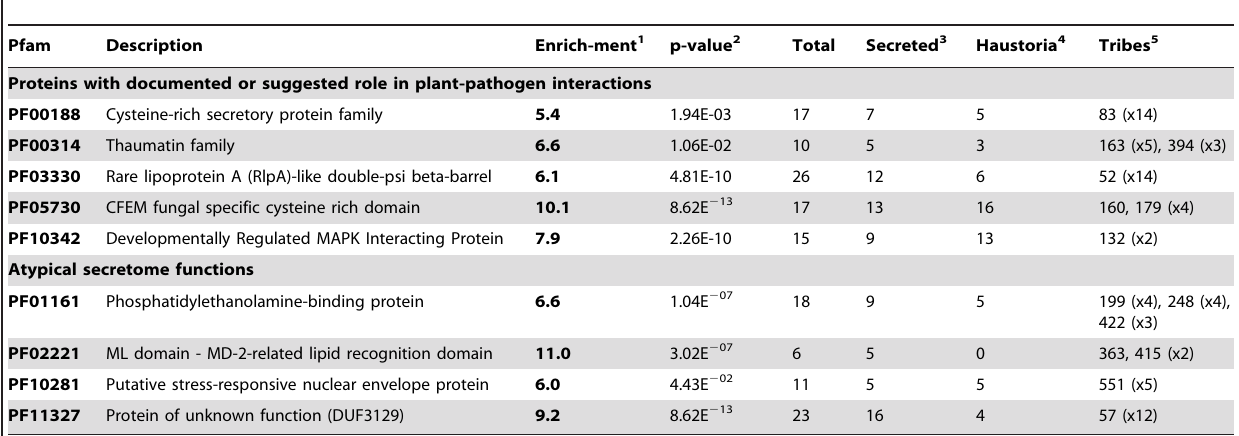
Table 1. Non-enzymatic PFAM domains significantly enriched in the secretome of rust fungi.